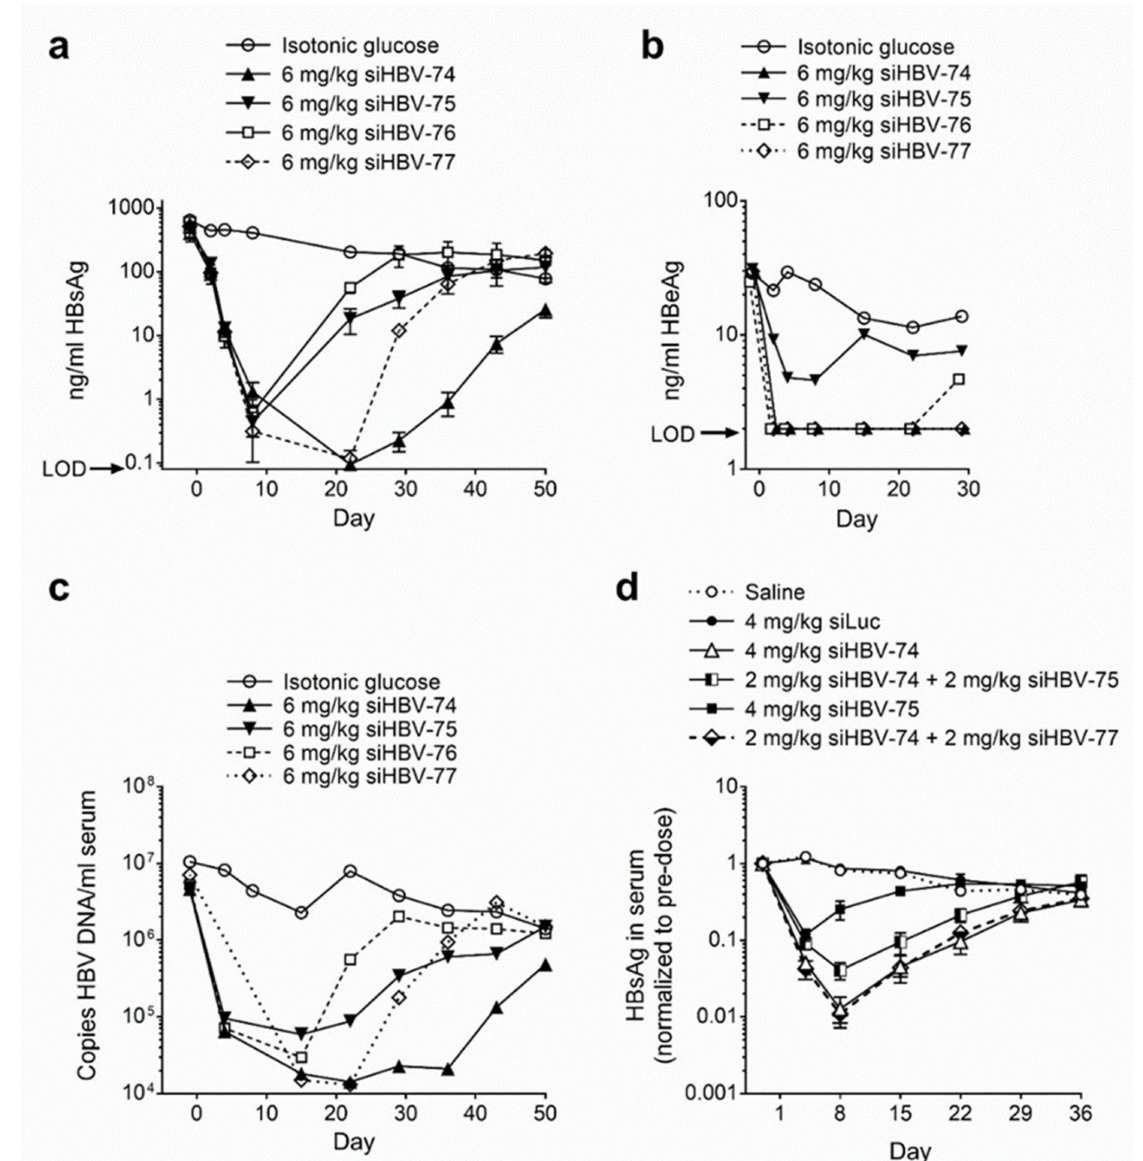
Figure 2. Efficacy and duration of knockdown following co-injected cholesterol-conjugated HBV siRNA and excipient NAG-MLP in mouse model of chronic HBV infection. NOD-SCID mice were given a hydrodynamic tail vein injection with ( a – c ) 10 µ g pHBV1.3 or ( d ) 5 µ g MC-HBV1.3. Three or more weeks thereafter, mice ( n = 3–4) were given one 200 µ L IV coinjection of 6 mg/kg NAG-MLP and 6 mg/kg chol-siRNA siHBV-74, -75, -76, or 77 ( a – c ) or 4 mg/kg NAG-MLP and 4 mg/kg chol-siRNA as indicated ( d ). ( a , d ) HBsAg and ( b ) HBeAg in serum were measured by enzyme linked immunosorbent assay at the indicated times relative to injection on day 1; LOD, limit of detection. ( c ) DNA was isolated from serum and the concentration of HBV genomes was quantitated by qPCR. Reproduced from [23] by permission of American Society of Gene and Cell